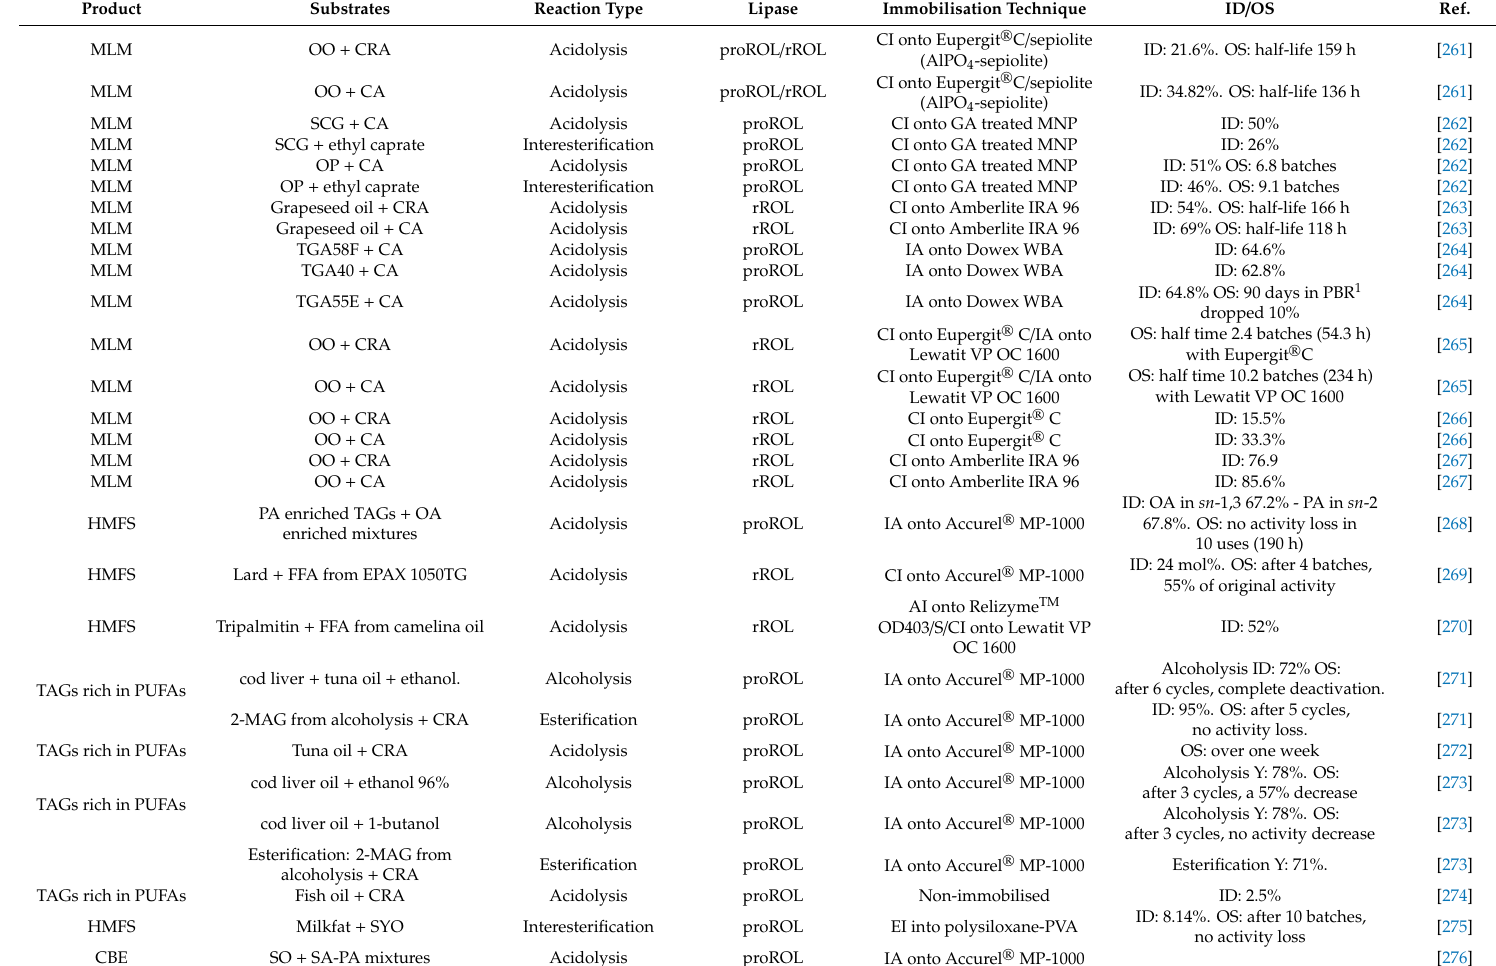
Table 7. Summary of structured lipids production with Rhizopus oryzae lipase as main